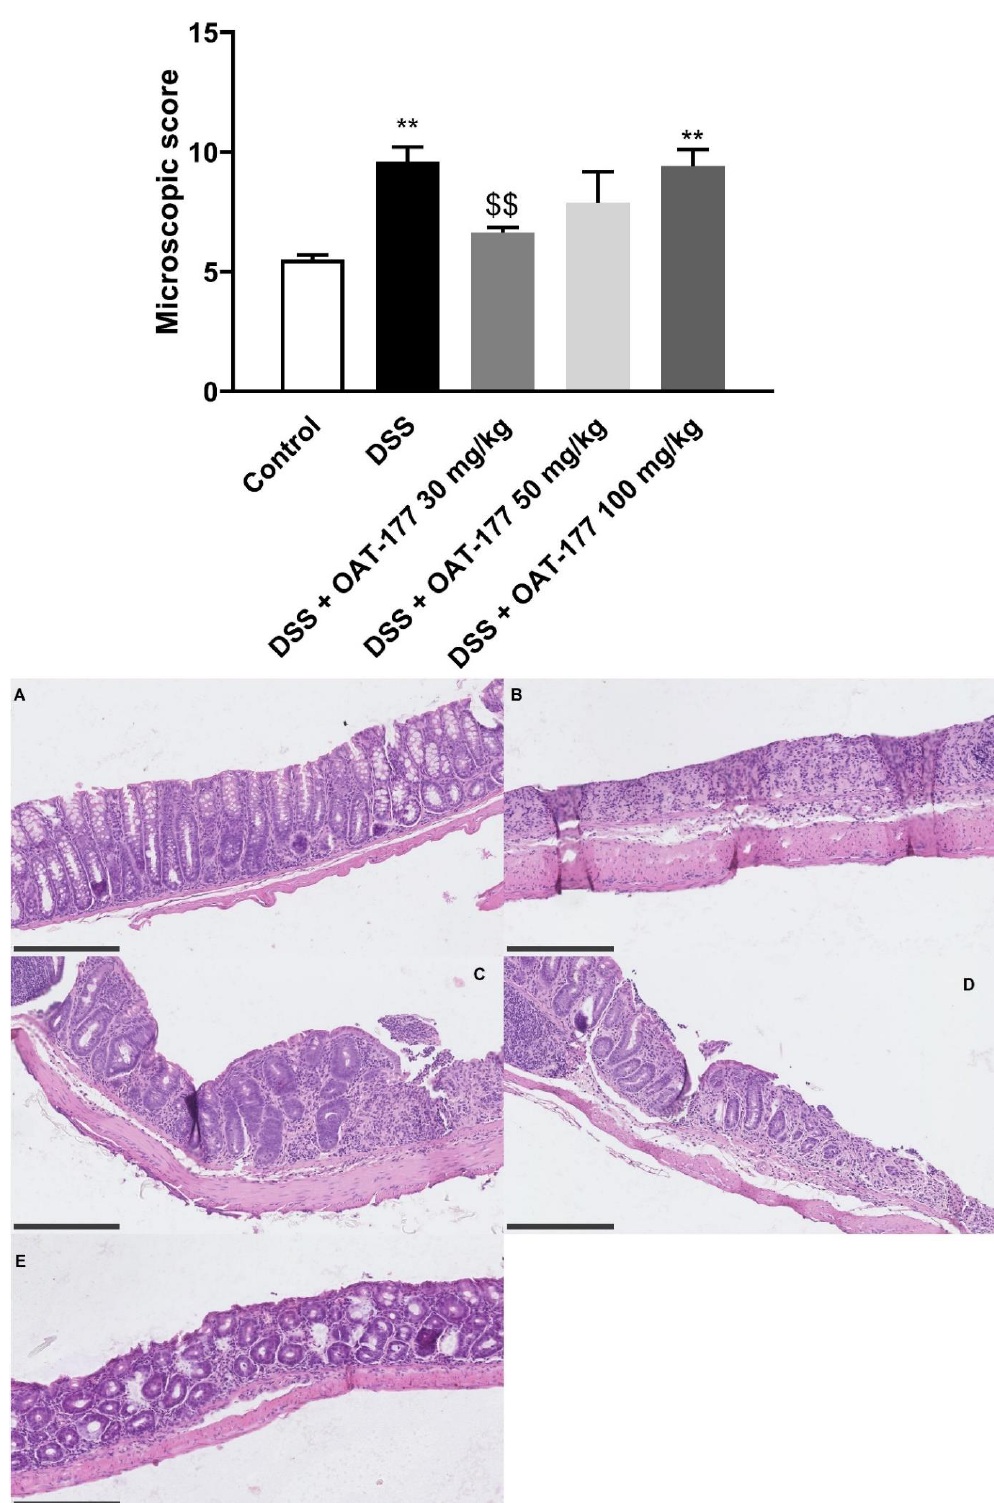
Figure 2. The effect of OAT-177 administered intragastrically in the short-term therapeutic protocol on the microscopic score in a dextran sulfate sodium (DSS)-induced colitis. Data are expressed as mean ± SEM. The statistical significance from the one-way ANOVA, Tukey’s post hoc test: ** p < 0.01 vs. control group; and $$ p < 0.05 vs. DSS-only treated group. Representative photos of hematoxylin and eosin staining of colon samples (( A ): control group; ( B ): DSS-only treated group; ( C ): OAT-177 30 mg/kg; ( D ): OAT-177 50 mg/kg; and ( E ): OAT-177 100 mg/kg). Scale bar = 250 µ